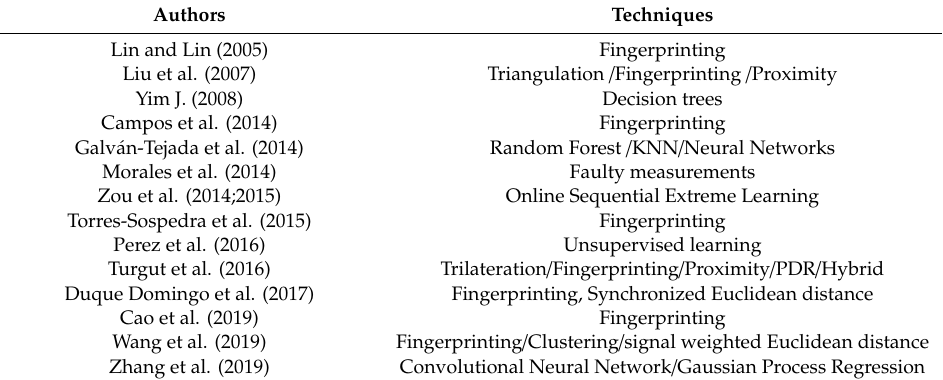
Table 1 summarized the Wi-Fi studies with the employed technique. Table 1. Overview of studies that utilize Wi-Fi technology for indoor positioning.